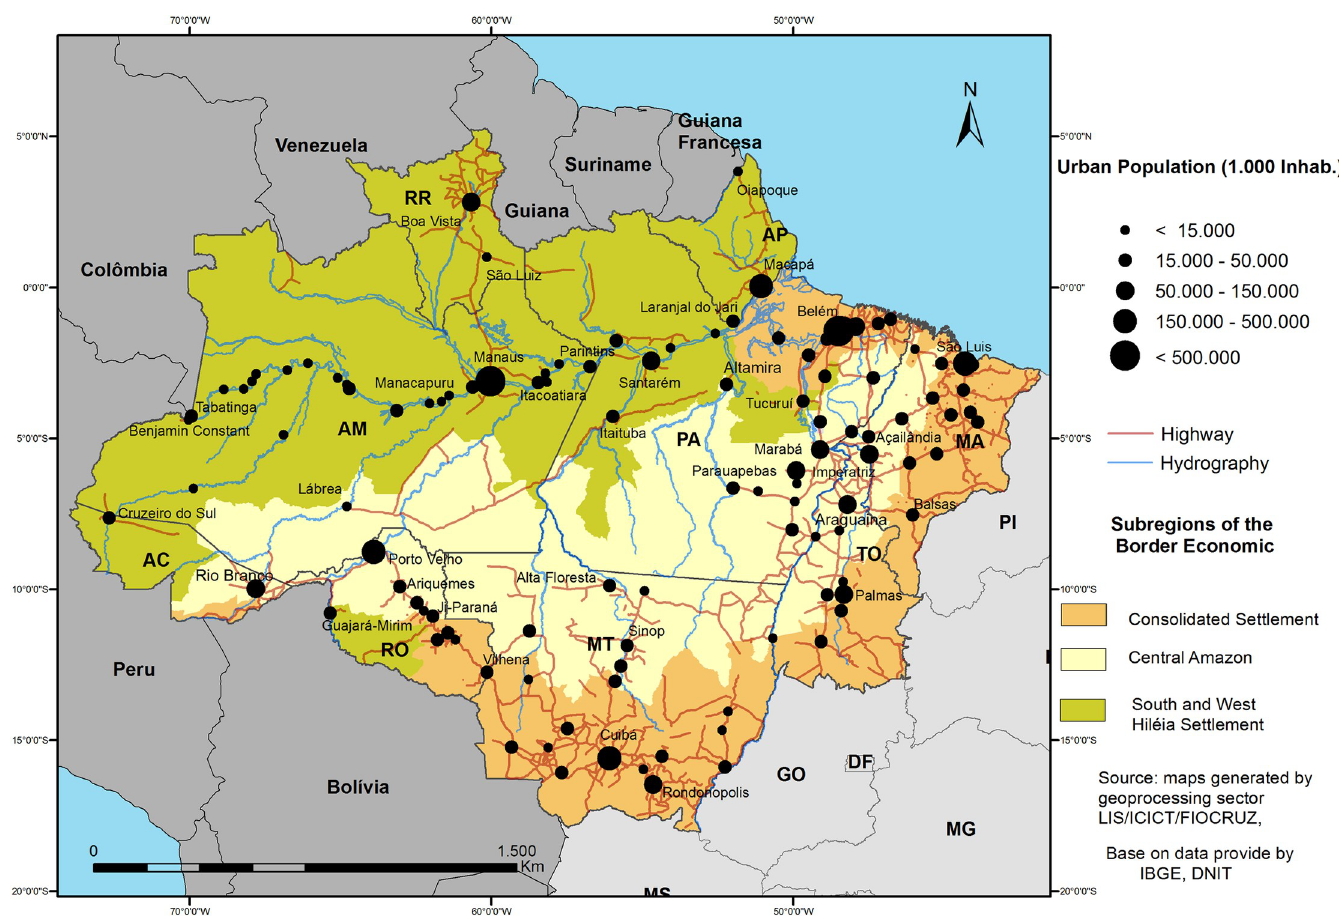
Fig 1. Range of economic frontier occupation: cities, highways, and